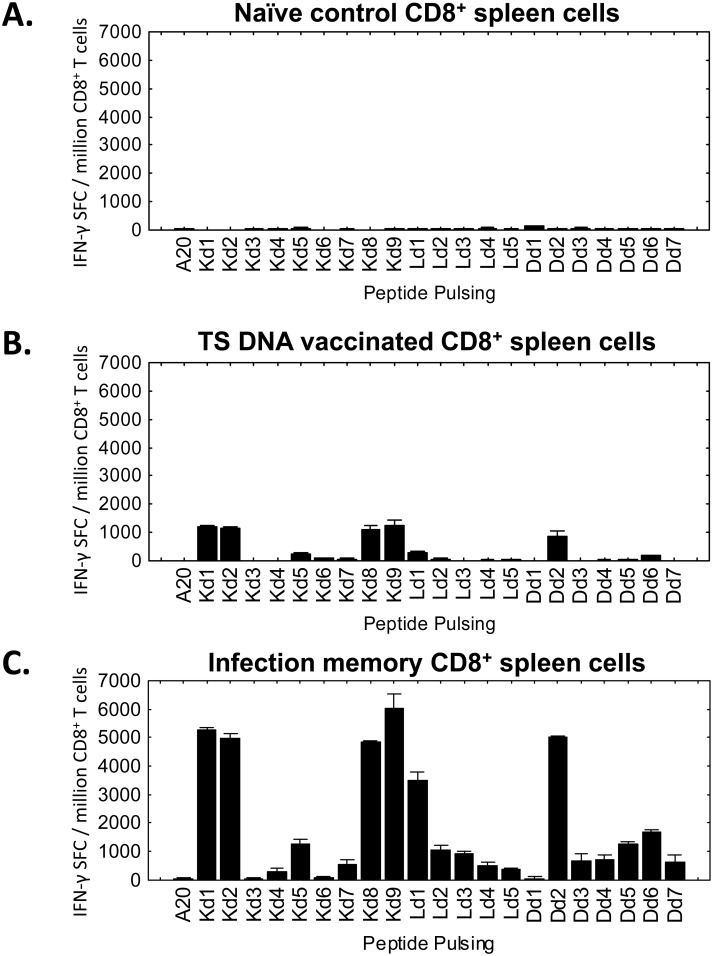
Identification of trans-sialidase MHC class I-restricted T cell epitope(s).TSaa359-367 (TSKd1) has been observed to be an immunodominant epitope during both TS vaccination and T. cruzi infection. We utilized a consensus immunoinformatic approach using several MHC prediction tools to identify other TS sequences predicted to bind BALB/c MHC (H2-Kd, H2-Dd, and H2-Ld, shown in S1 Table). APC (A20) were pulsed with these synthetic peptides and used to stimulate purified splenic CD8+ T cells from naïve (A), WT TS DNA-vaccinated (B), and T. cruzi “Infection Memory” mice (C) in overnight IFN-γ ELISPOT assays. Infection Memory (C) was induced by multiple, virulent Tulahuen strain T. cruzi challenges, resulting in mice with potently protective T cell immunity directed against a variety of parasite antigens and epitopes. Nearly all of the predicted peptides elicited memory T cell IFN-γ responses in mice previously infected with T. cruzi and mice vaccinated with WT TS DNA. Results are representative of 3 independent experiments.